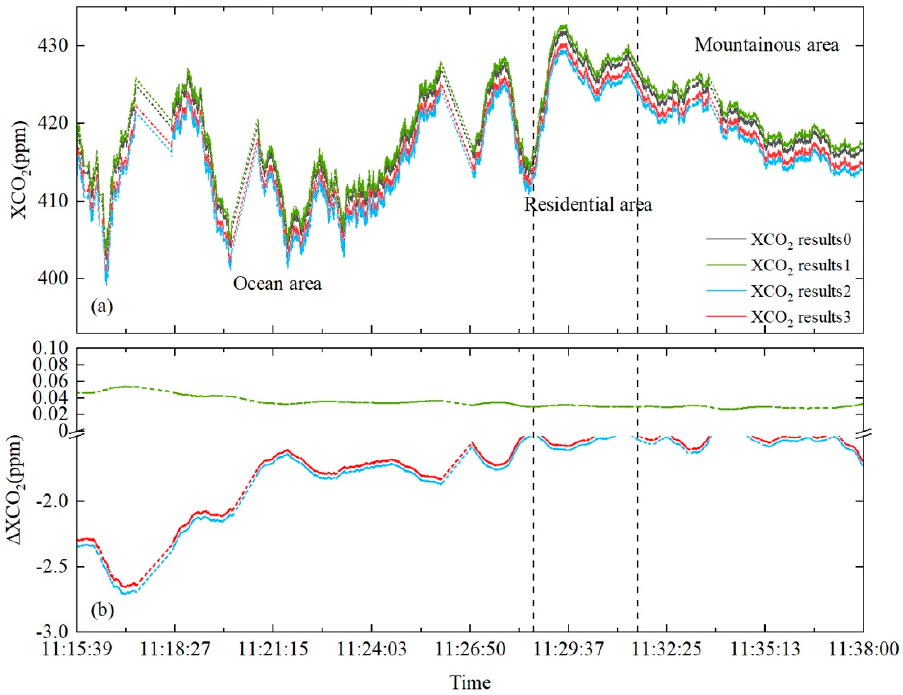
Figure 10. Comparison of the XCO 2 retrievals from the IPDA measurements on 14 March 2019: ( a ) original and Doppler-shifted XCO 2 results. The black line represents original XCO 2 results, the blue and green lines represent the XCO 2 results with online and offline Doppler shifts, respectively, and the red line represents the XCO 2 results with Doppler shifts of both wavelengths; ( b ) difference in XCO 2 between the original and Doppler-shifted results. The blue and green lines represent the difference between the original, XCO 2 results2, and XCO 2 results1, and the red line represents the difference between the original and XCO 2 results3.